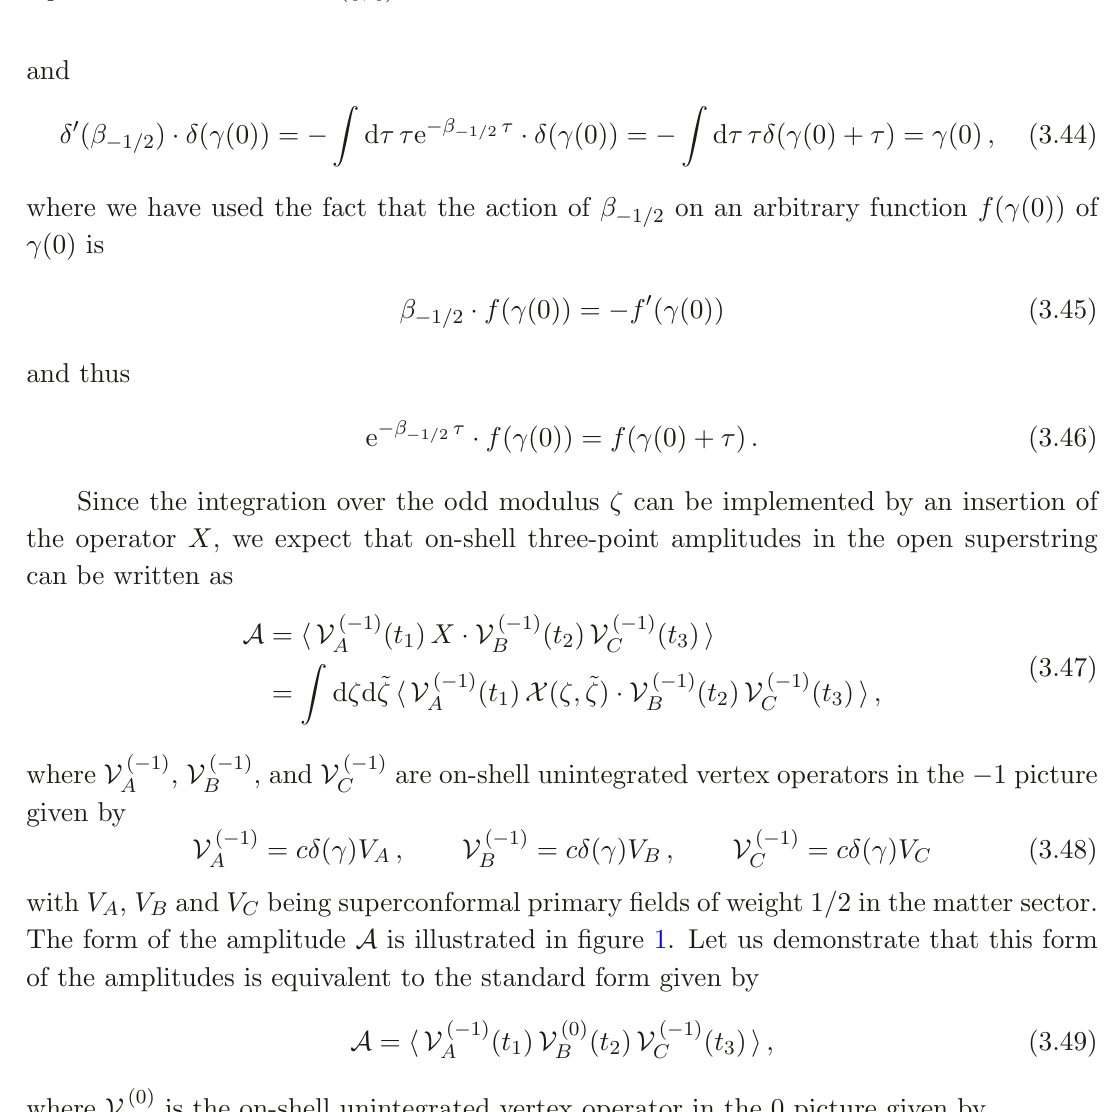
Figure 1 . The form of on-shell three-point amplitudes in the open superstring. The blue line represents the insertion of X ( ζ, ˜ ζ